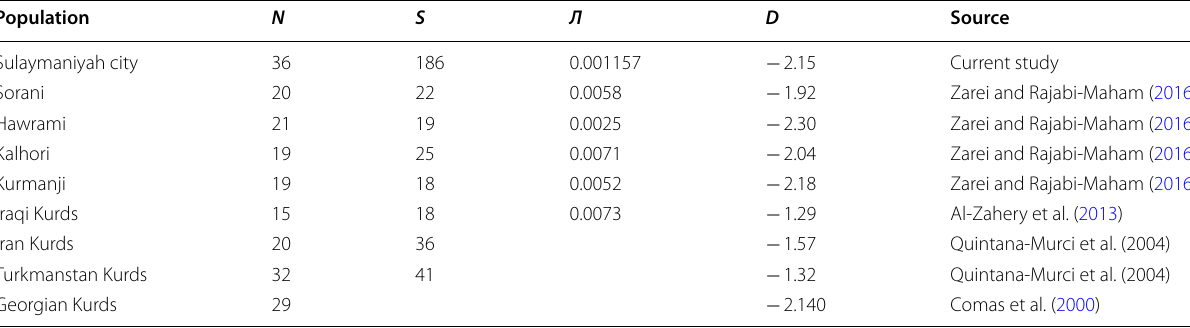
N number of samples, S number of segregating sites, Л nucleotide diversity, D Tajima’s test statistic